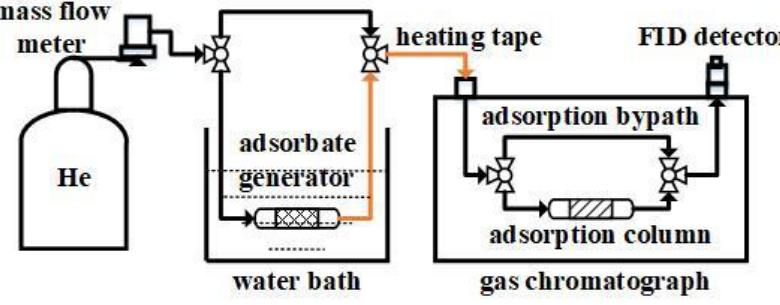
Figure 1. Schematic diagram of experiment system for Nap adsorption.